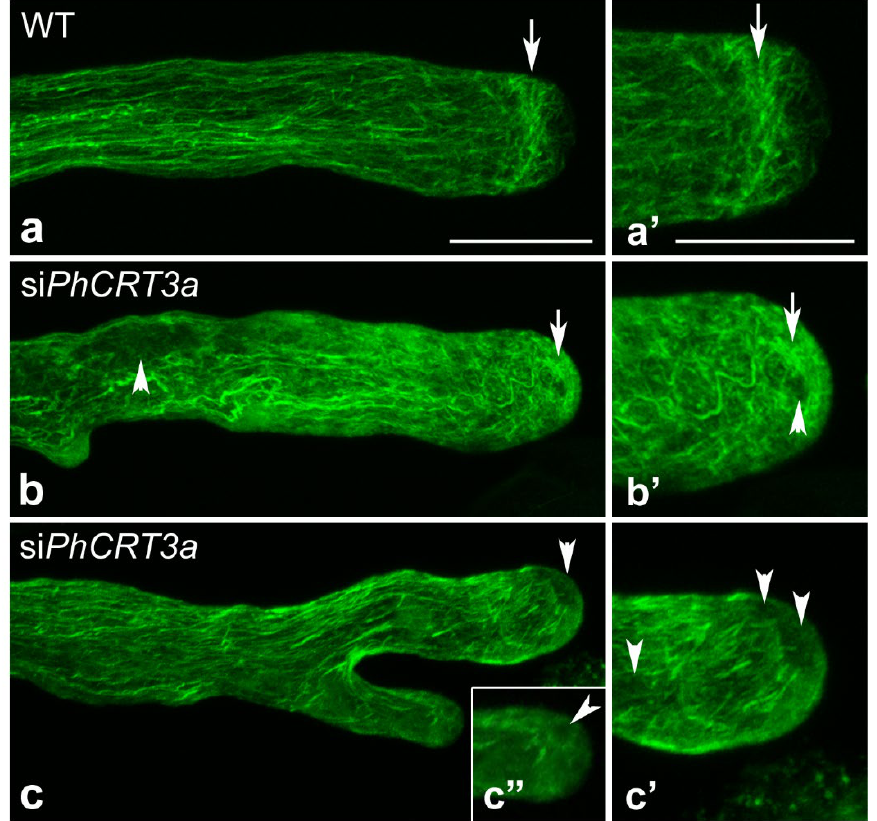
Figure 9. F-actin staining in WT and si PhCRT3a elongated pollen tubes. In WT pollen tubes, long actin filaments are distributed throughout the entire tube in a net axial array that is largely parallel to the direction of elongation, except at the very tip ( a , a’ ), and a distinct cortical actin fringe is formed in the subapical zone of the tube ( arrows in ( a , a’ )). By contrast, typical F-actin configurations are lost in the defined zones of si PhCRT3a - treated pollen tubes ( b – c” ), but abnormal actin aggregates are observed in the apical cytoplasm (arrows in ( b , b’ )) . Additionally, some ‘‘empty spaces’’ (probably vacuoles) are present in the apical/subapical zone (arrowheads in ( b’ , c , c’ , c” )), as well as in the distal shank (arrowhead in ( b )), of si PhCRT3a pollen tubes. Bar: 50 µm ( a – c ); 20 µm ( a’ – c” ).